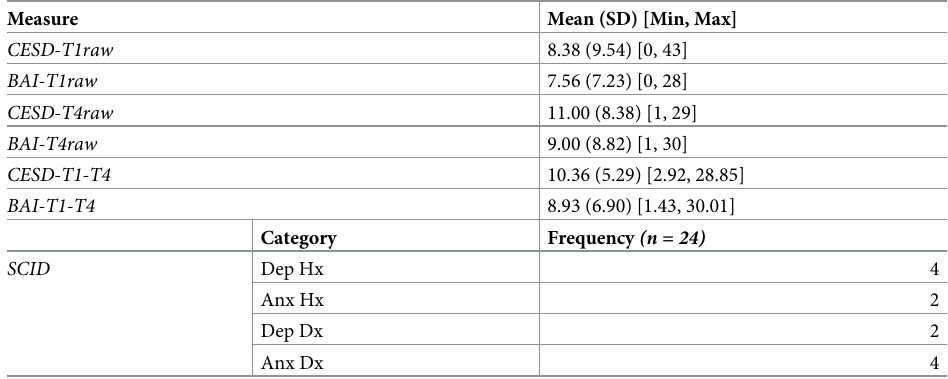
Table 2. Psychopathology data for mothers included in final